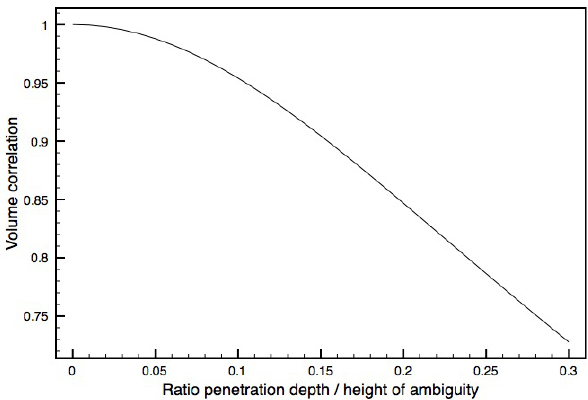
Figure 6. Volume correlation | γ Vol | as a function of the ratio d/h a_Vol (Eq.